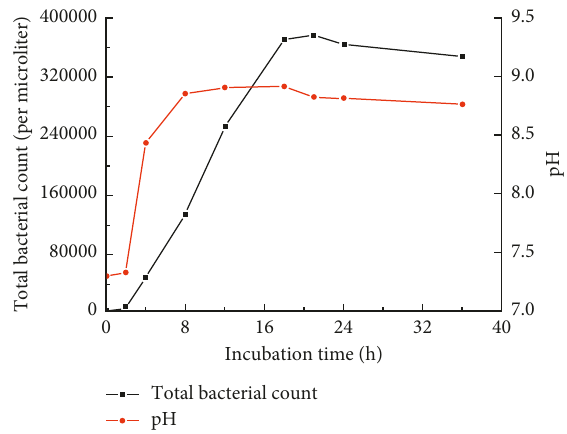
Figure 6: Uranium tailings reinforced by MICP.